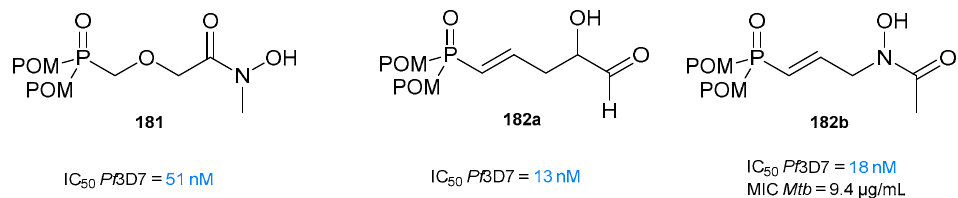
Figure 35. Structure and antiplasmodial activity of prodrugs 181 and 182 .